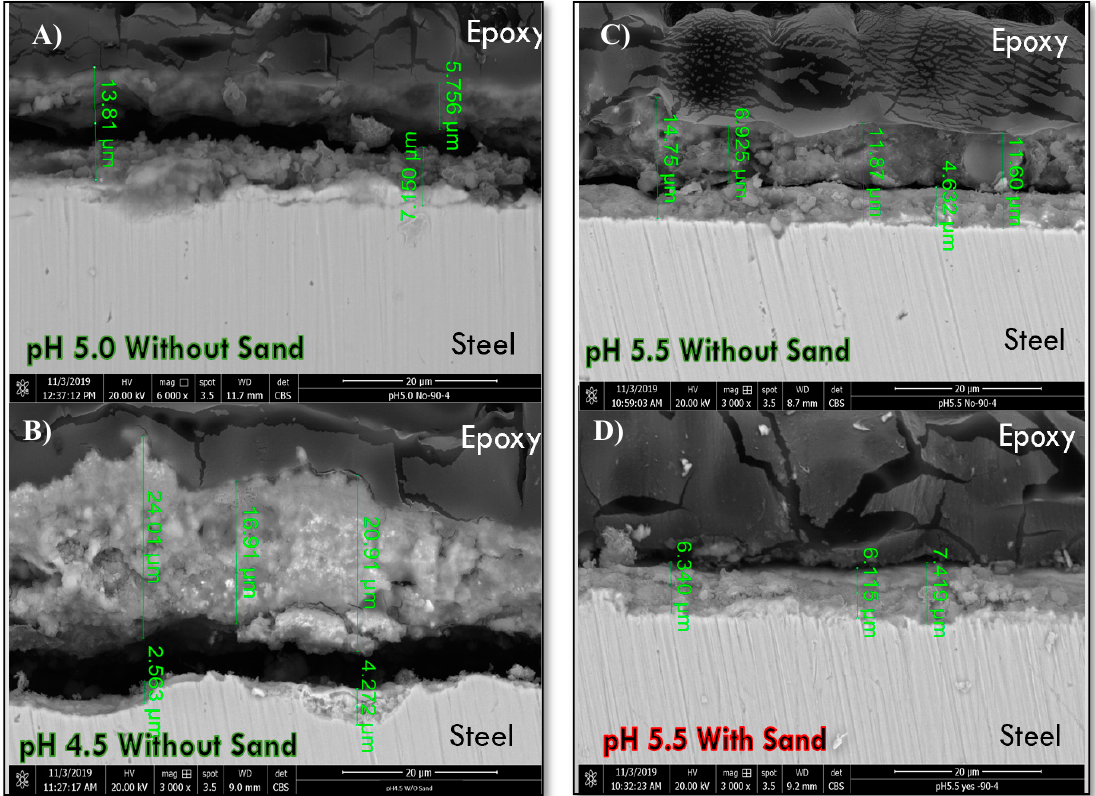
Figure 8. Cross-sectional FE-SEM backscattered images for API 5L X65 tested in CO 2 EC at an impingement angle of 90°, room Temperature, impingement velocity of 8 m/s: ( A ) pH 5.0 without sand, ( B ) pH 4.5 without sand, ( C ) pH 5.5 without sand, and ( D ) pH 5.5 with sand.